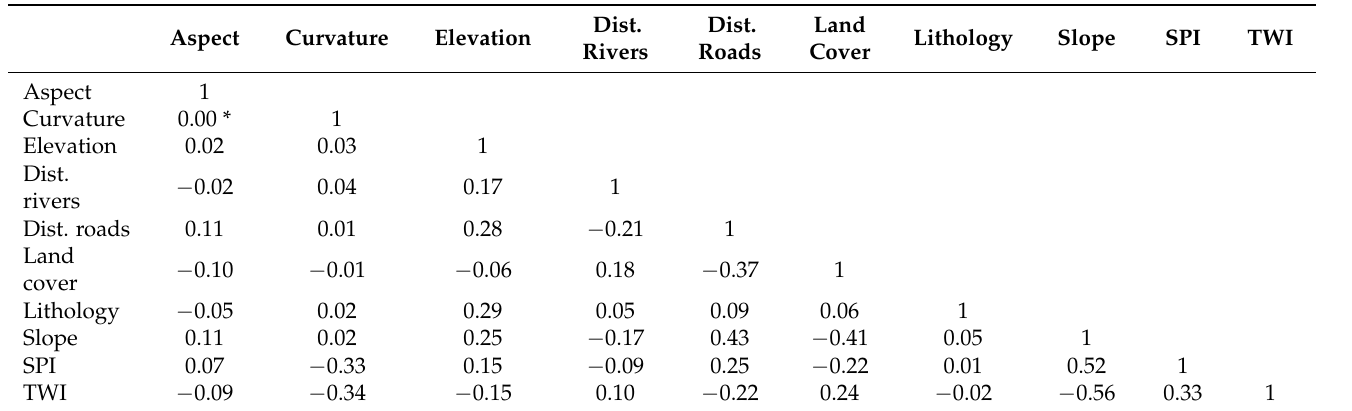
Table 5. Spearman’s correlation values for conditioning